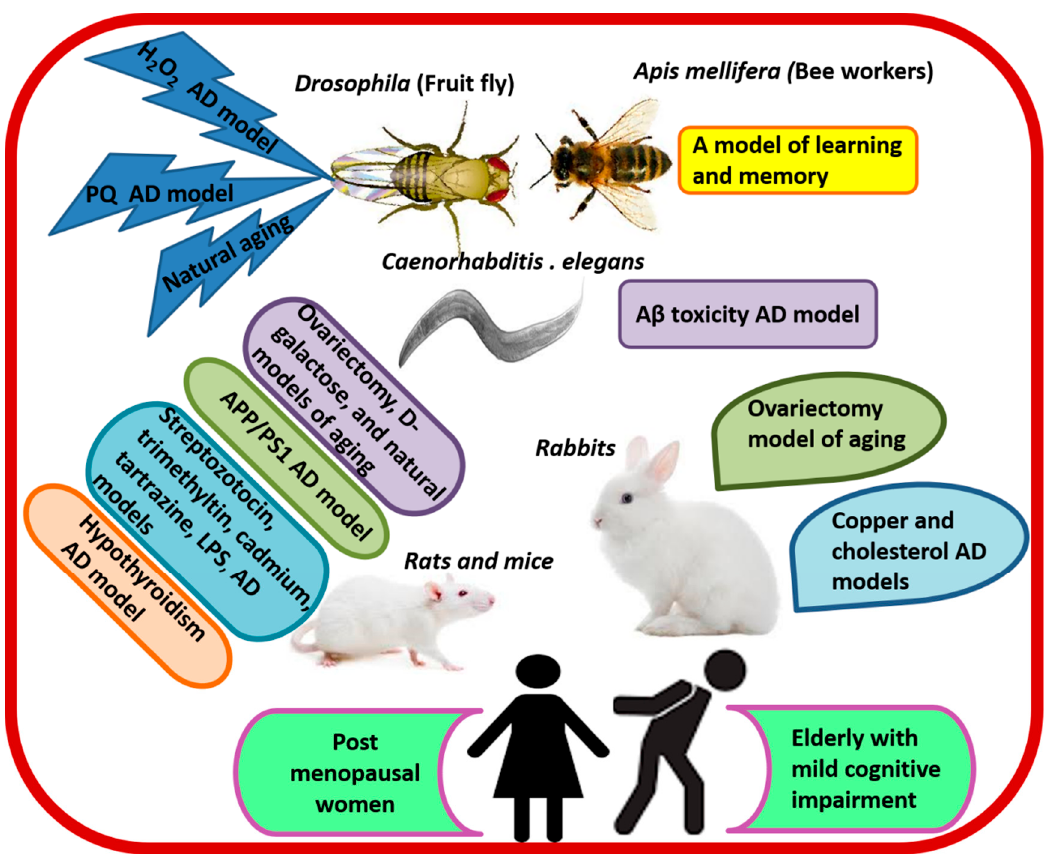
Figure 4. Royal jelly improves cognitive function-related parameters in various animal models and in humans. Abbreviations: AD: Alzheimer’s disease, PQ: paraquat, H 2 O 2 : hydrogen peroxide, A β : beta-amyloid peptide, APP/PS1 mice express 2 mutations associated with early-onset AD—chimeric mouse/human APP (Mo/HuAPP695swe) and human PS1 (PS1-dE9), LPS: lipopolysaccharide.